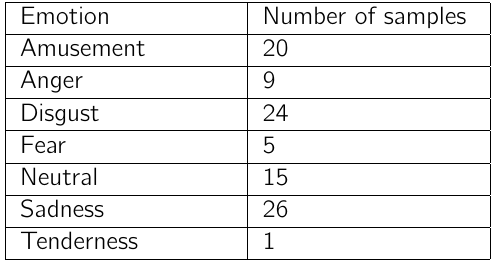
Table 1: Category of emotion and how many times the emotion was